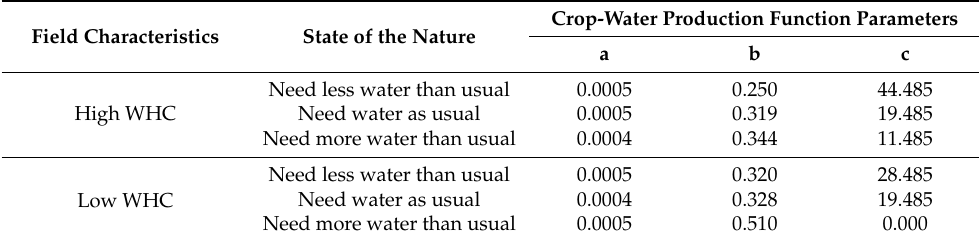
Table A3. Crop water production functions estimated for each state of the nature and field conditions using the methodology developed by Linker et al. [38].